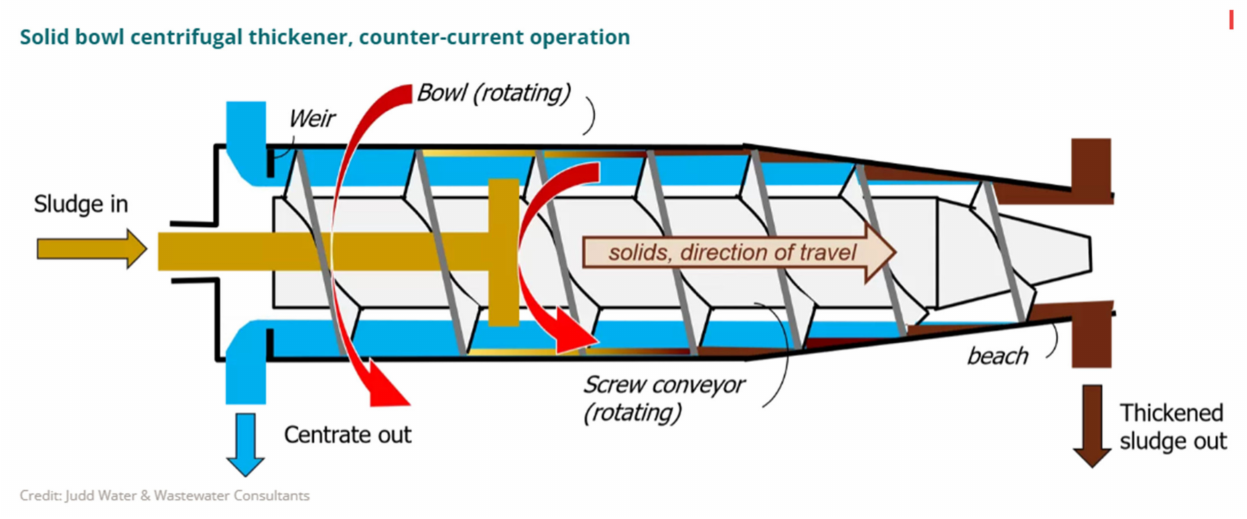
Figure 4. Decanter centrifuge